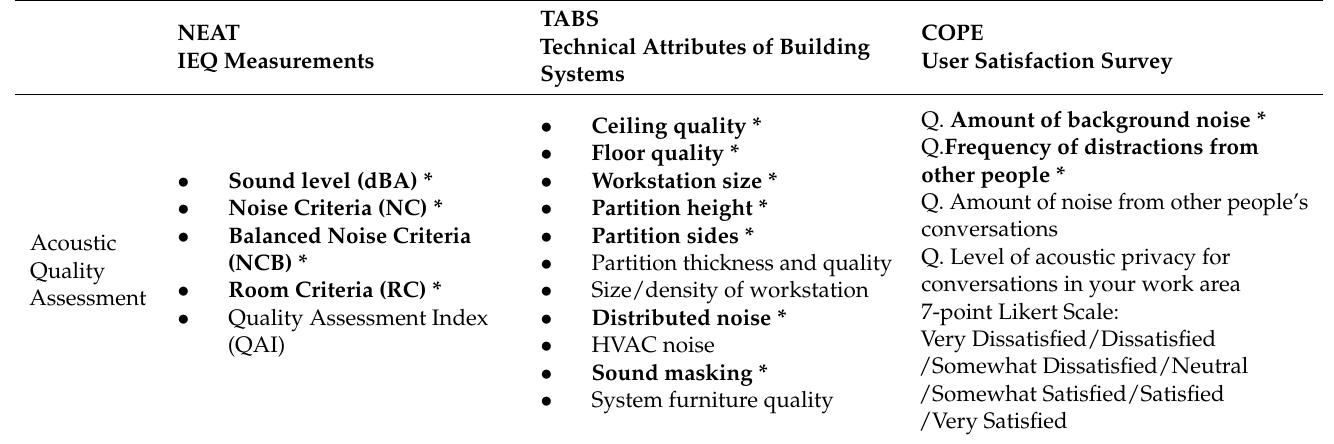
Table 4. This is a table. Tables should be placed in the Acoustic quality datasets considered for each